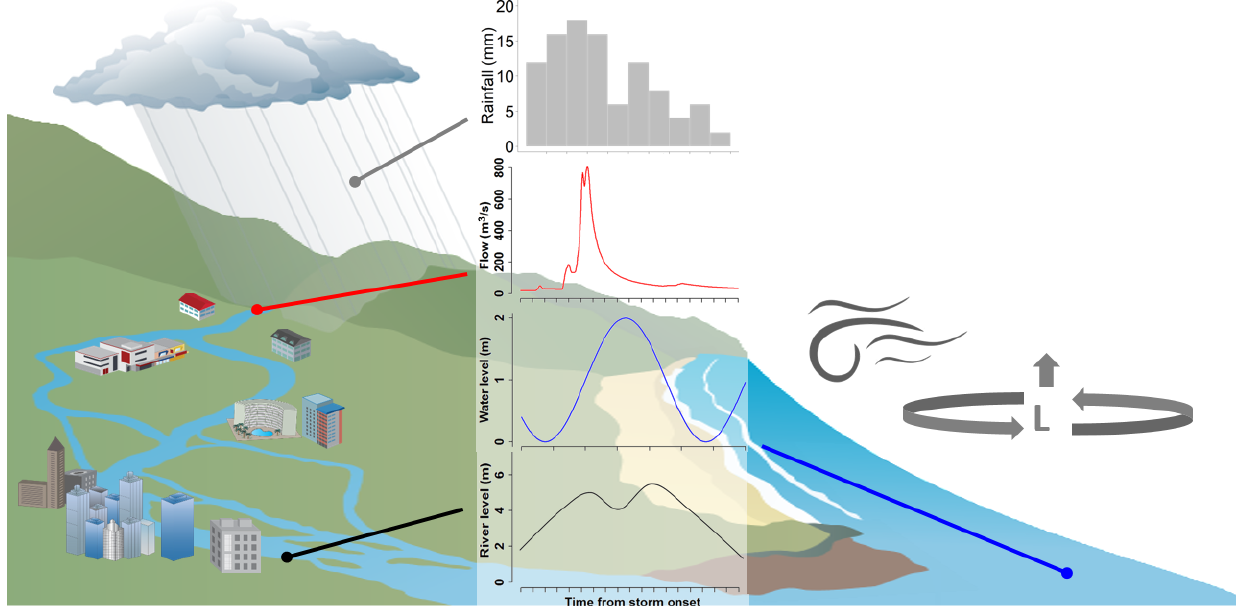
Figure 1. Processes that commonly lead to flooding in estuarine regions with common meteorological drivers such as wind and the inverse barometric effect. Extreme rainfall can cause significant streamflow events in upstream or local urban regions, which may combine with elevated ocean levels at the lower estuarine boundary. The specific flood magnitude depends on the timing and magnitude of constituent